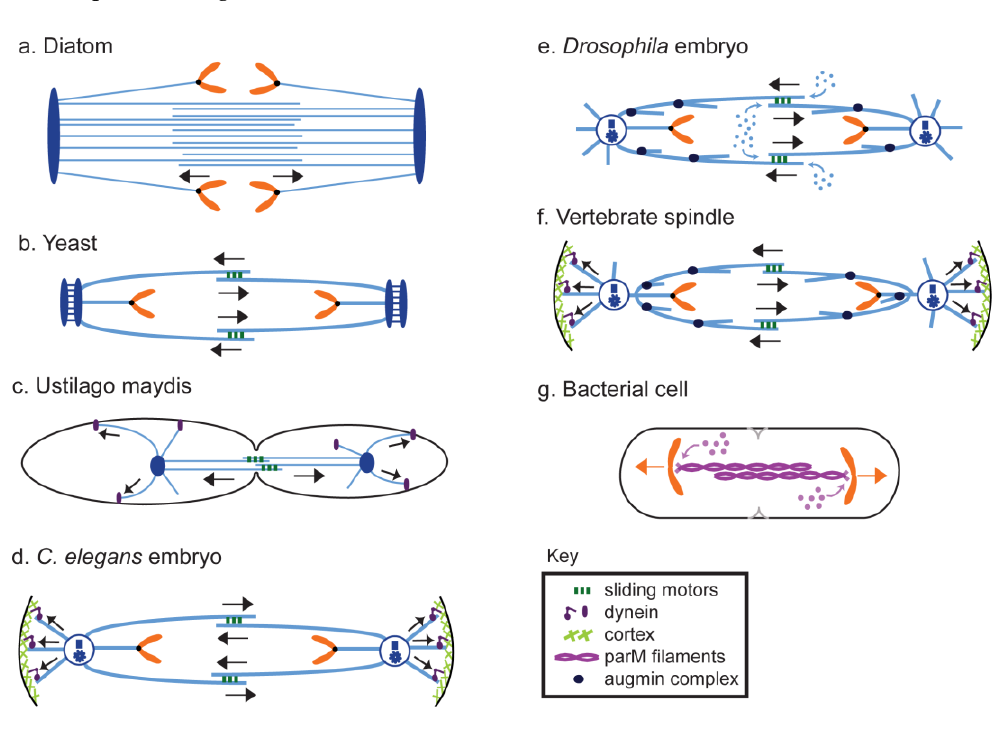
Figure 6. Anaphase B spindle design in different systems. The simplified drawings depict spindles from ( a ) diatoms; ( b ) budding yeast; ( c ) the rust fungus Ustilago ; ( d ) early C. elegans embryos; ( e ) Drosophila syncytial embryos; ( f ) vertebrate cultured cells; and ( g ) bacterial cells. Not drawn to scale.